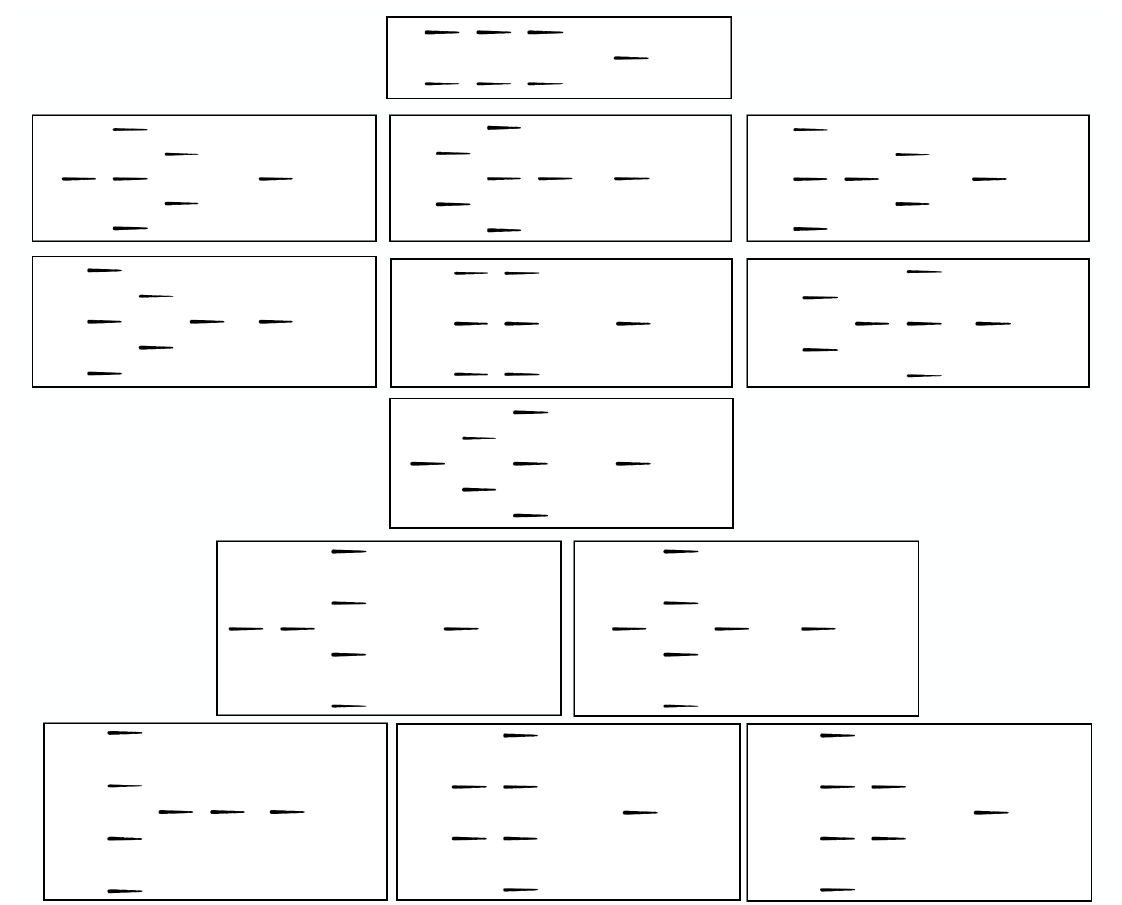
Figure A5. Configurations for six leading